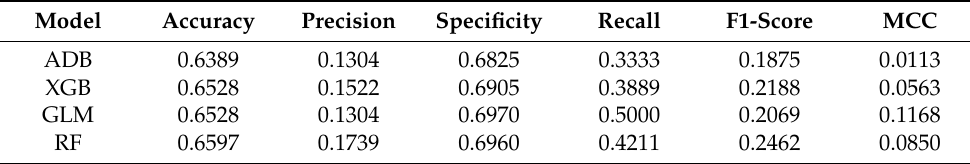
Table 3. Machine learning classifier performance (%) for vascular aging detection. Model